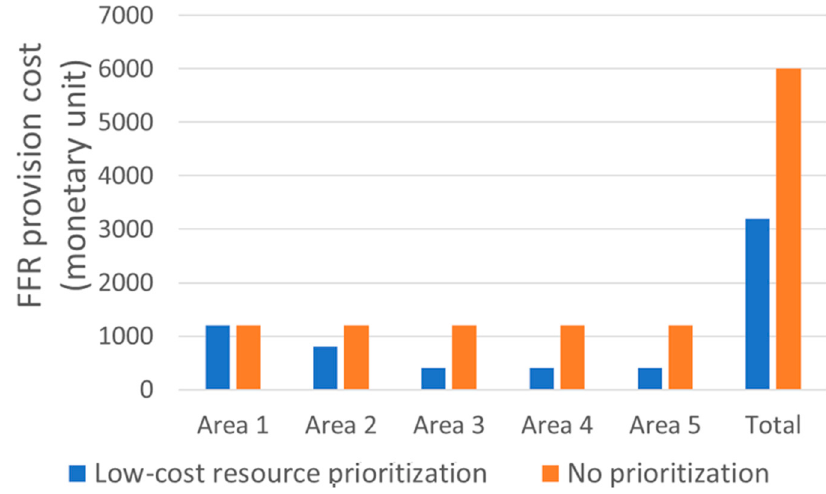
Figure 25. Provision costs of FFR service for the IEEE 68.